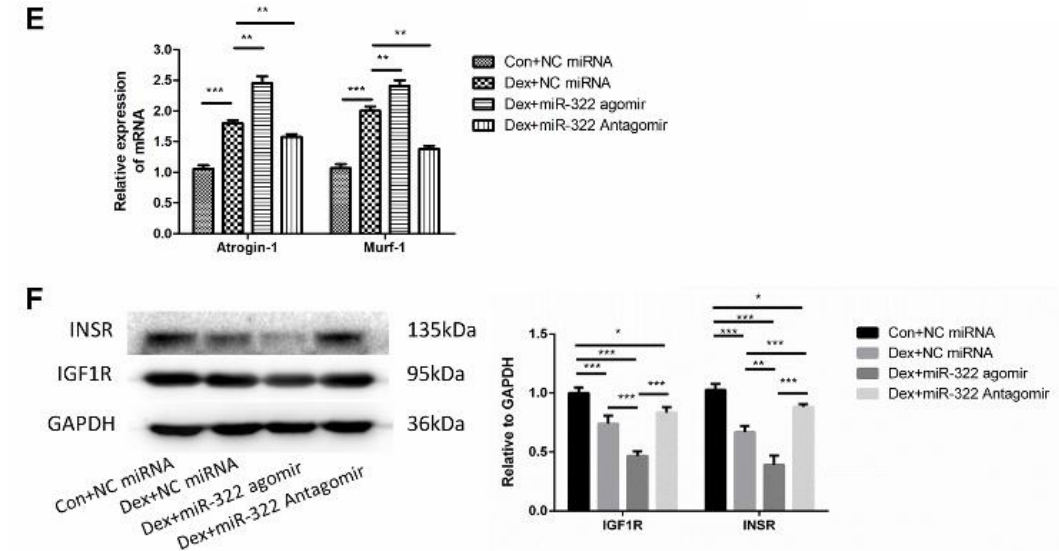
Figure 6. miR-322 aggravated Dex-induced muscle atrophy in vivo. ( A ) qRT-PCR analysis showed the expression of miR-322 ( B ) Gastrocnemius weight/body weight (GW/BW) ratio in mice was showed. ( C ) Grip strength of the right hind limb was showed. ( D ) HE staining (400×) showed muscle fiber diameter in mice. ( E ) qRT-PCR analysis showed Atrogin-1 and MuRF-1 expression levels in mice. ( F ) Western blot analysis showed increased expression of IGF1R and INSR in vivo. Scale bar, 10 µm. NC, negative control. Dex, dexamethasone. * p < 0.05, ** p < 0.01 and *** p < 0.001.